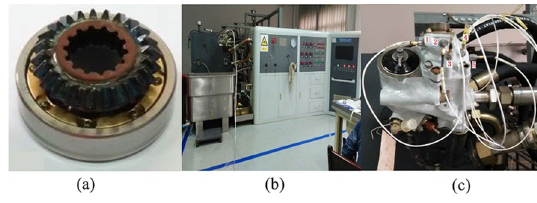
Figure 13 a Aeroengine bevel gear; b lubricating oil accessory testing bench; c sensor position